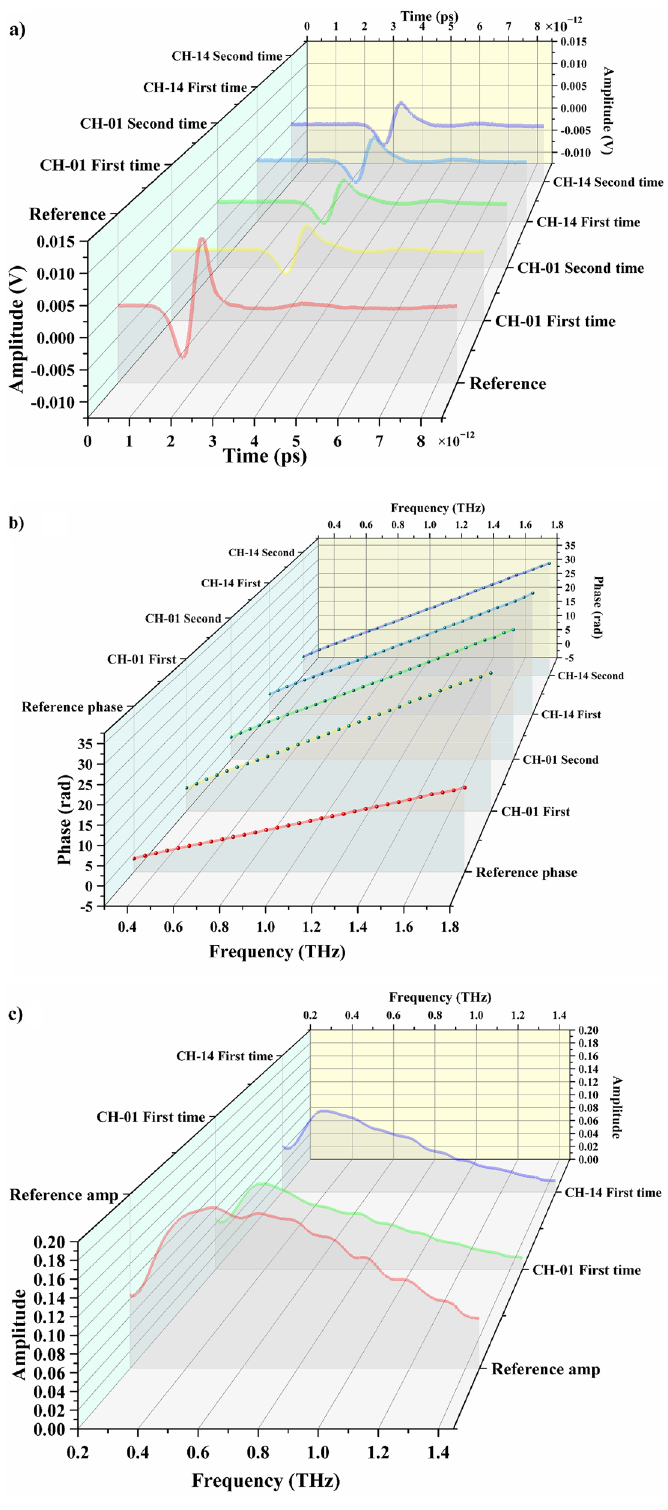
Figure 1. Results of terahertz measurements on raw bentonite samples. Terahertz time-domain spectra ( a ). Phase diagrams for two sets of raw bentonite samples ( b ). Frequency-domain spectra ( c ). The experiments were carried out at the temperature of 293.15–298.15 K, the pressure of one atmosphere and the humidity of air inside the setup <